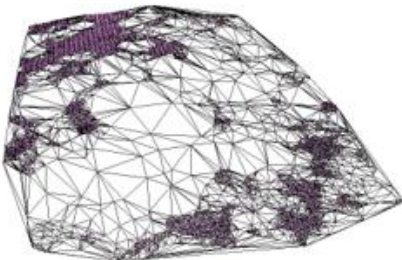
Figure 7. Final Triangulation – Zone 3 (Post Densification) The densified point cloud was gridded using IDW interpolation with a grid size of 0.5 meters. The DEMs for the three zones are illustrated figure 8.